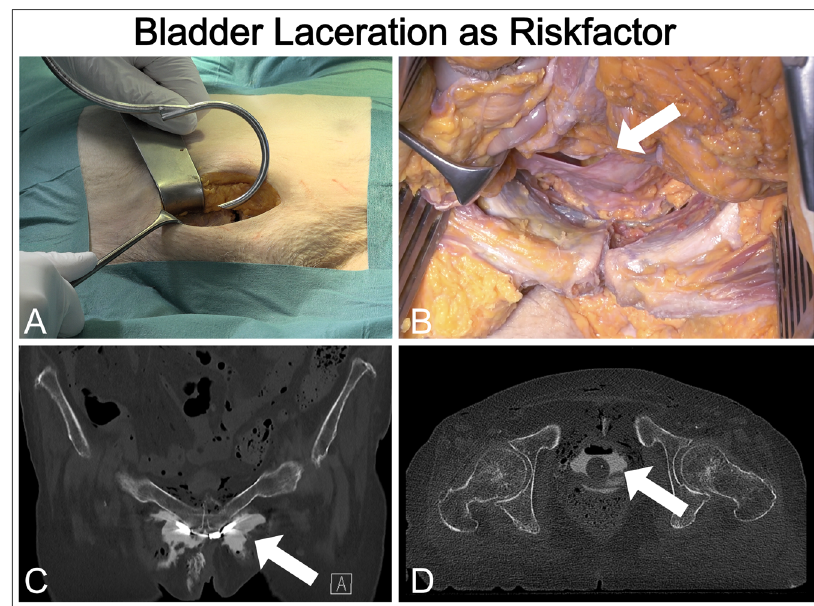
Fig. 9 Risk of bladder laceration during surgical procedure. Bladder laceration might result from vigorous application of an oversized curved cable passer during trans-obturator surgery with limited visibility. A Bladder laceration was observed in our cadaver study, where an oversized cable passer was used to transfer the cable from one side to the other. The bladder injury was con fi rmed by ( B ) visual inspection during preparation, and observation of ( C ) extravasation of contrast fl uid around the pubis symphysis and ( D ) entrapped air in the bladder in computed tomography (CT) images obtained before full anatomical